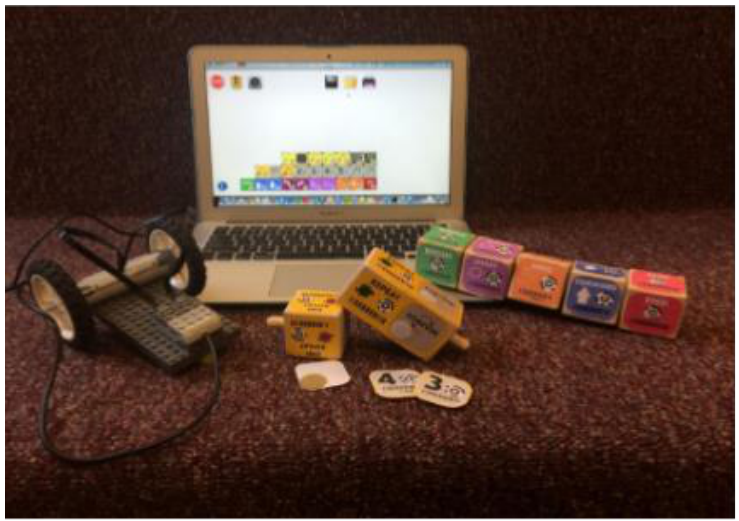
Figure 20. Creative Hybrid Environment for Robotic Programming (CHERP) tangible blocks, LEGO WeDo robotic kit with computer screen shows CHERP graphical user interface [38].